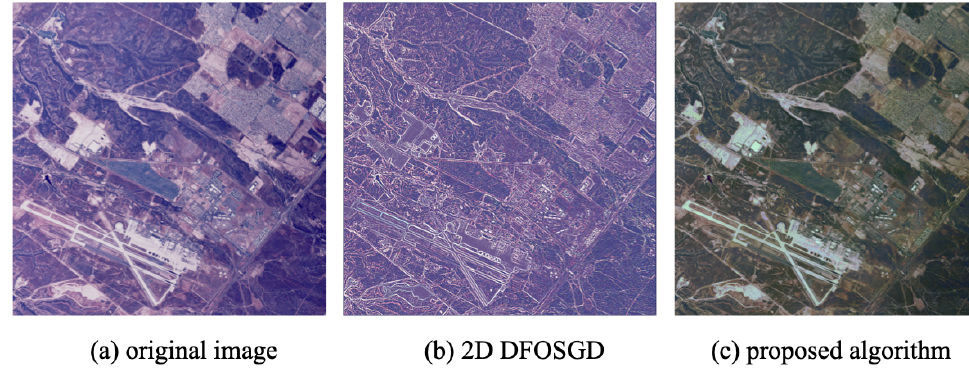
Figure 10. Enhancement results of image “2.1.01”.